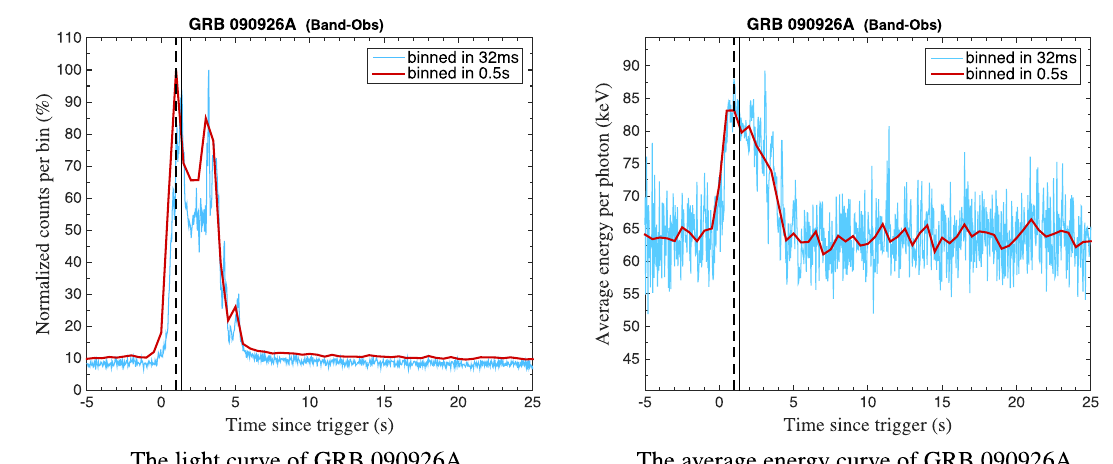
Fig. 8 The light curve and average energy curve of GRB 090926A in Band-Obs. The vertical solid lines refer to t obs /( 1 + z ) of Criterion 0 (the first main peak of the light curve) and the vertical dashed lines refer to t obs /( 1 + z ) of Criterion 2 (the significant peak of the average energy curve)